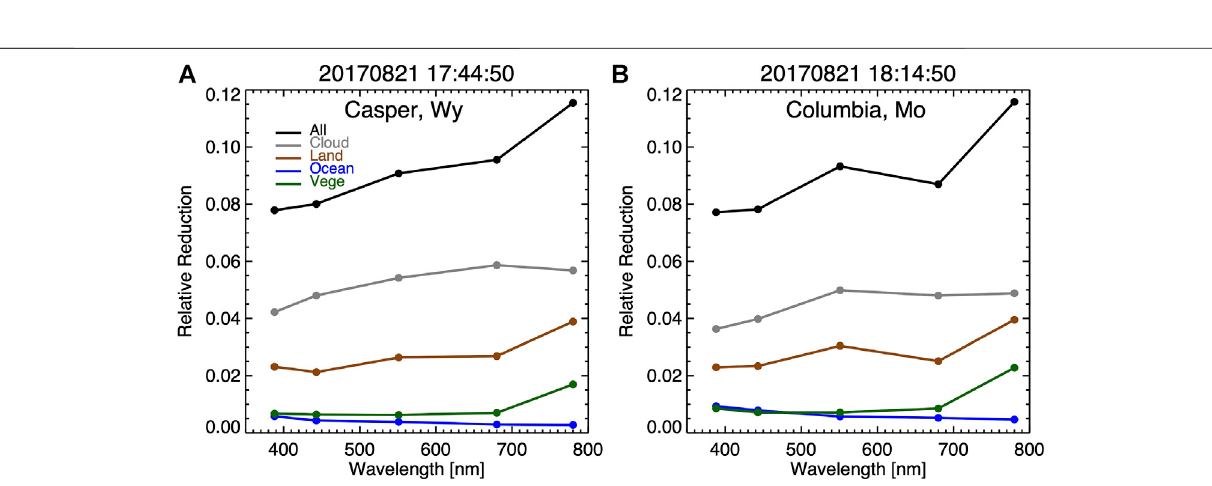
Frontiers in Remote Sensing |